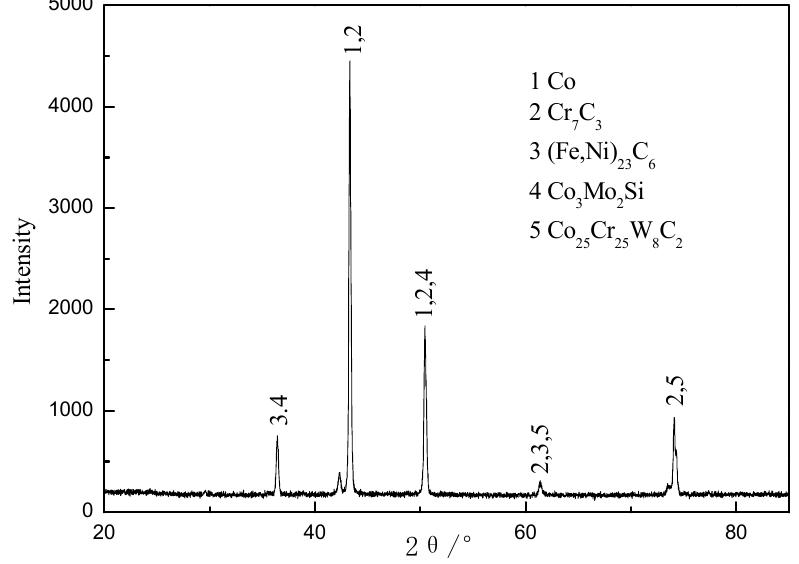
Figure 8. X ‐ ray diffraction (XRD) pattern of the Co ‐ based cladding layer.